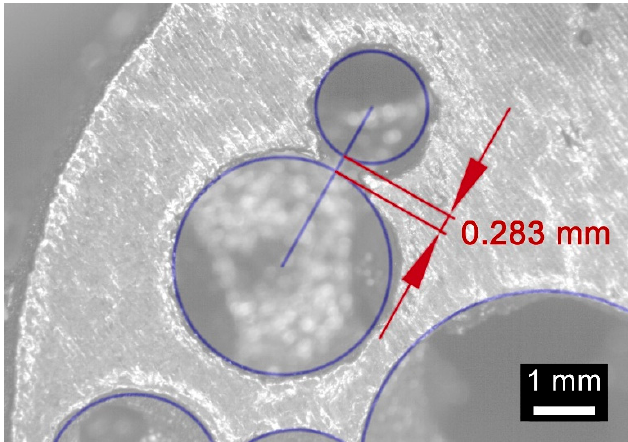
Figure 17. Detail of collapse at the interface between pores, nominal geometry is superimposed.